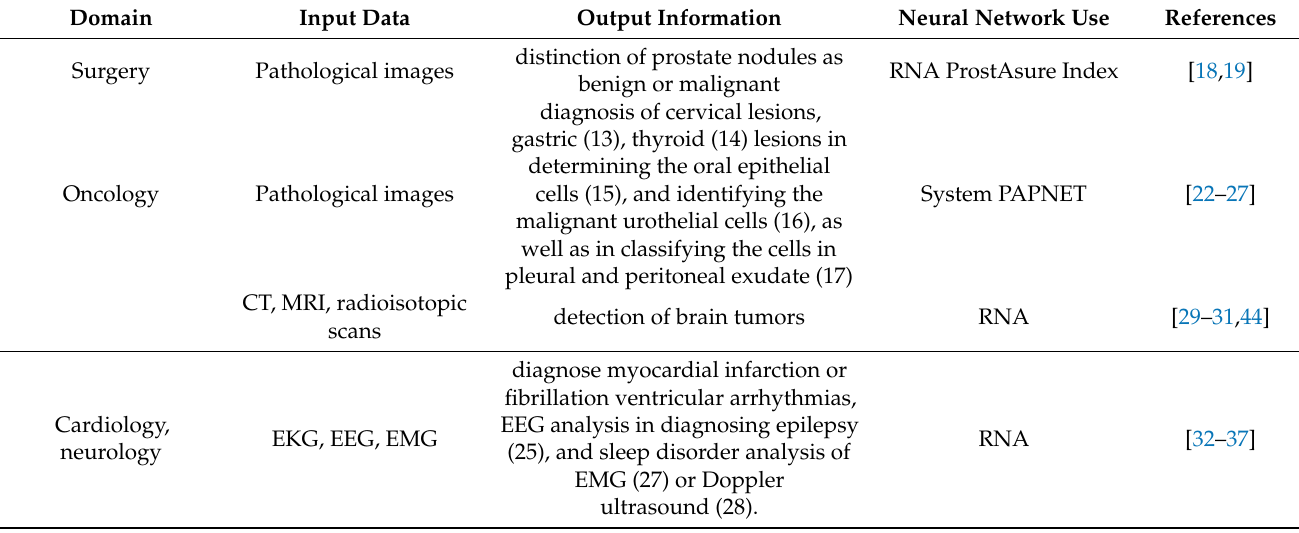
Table 1. Medical artificial intelligence